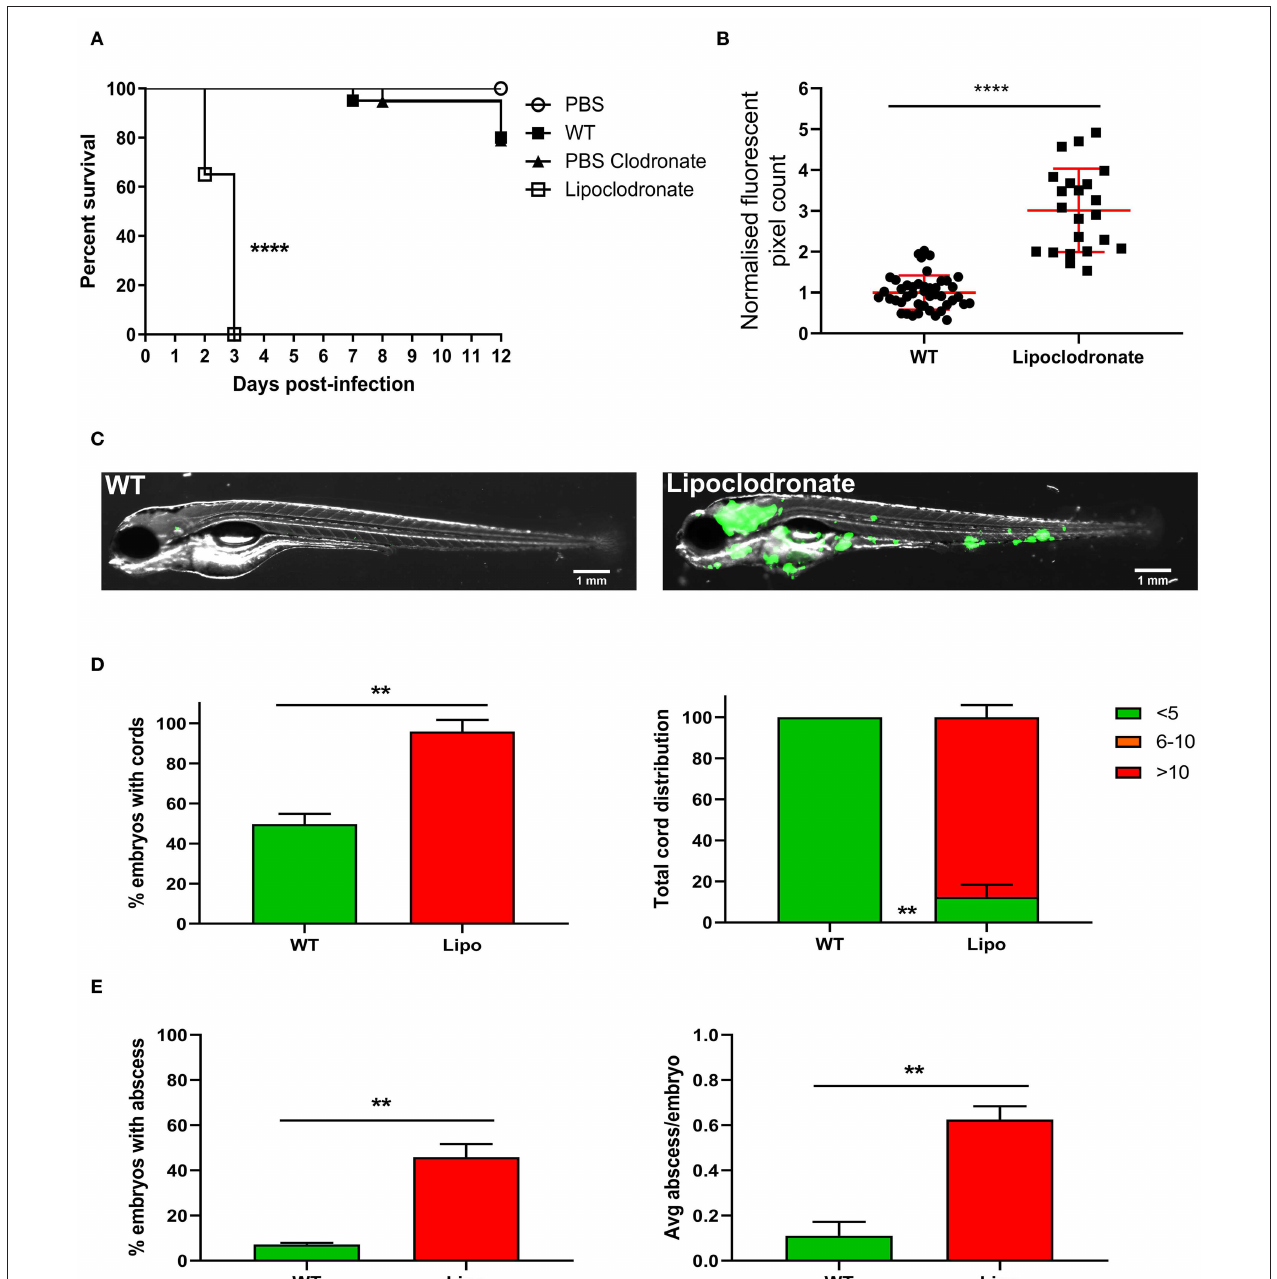
FIGURE 4 | Lipoclodronate macrophage depletion results in lethal M. fortuitum infection. (A) At 24h post-fertilization, embryos were treated with liposomal clodronate via caudal vein injection to transiently deplete macrophages. At 30h post-fertilization, embryos were injected intravenously with 300 CFU of GFP-expressing M. fortuitum with embryo survival monitored over a 12 day period. n = 20–25 embryos/group. Statistical analysis was completed using the log-rank (Mantel-Cox) statistical test for survival curves. Data shown is the merge of two independent experiments. (B) Bacterial burden at 2 days post-infection was calculated using fluorescent pixel count (FPC) determination with ImageJ software. Lipoclodronate-treated embryos were normalized against corresponding controls in each experiment. Each datapoint represents an individual embryo. Error bars represent standard deviation. Statistical significance was determined by Student ′ s t -test. Plots represent a pool of 2 independent experiments containing approximately 20 embryos per group. (C) Representative images of wild-type (WT) and Lipoclodronate-treated embryos infected with 300 CFU of GFP-expressing M. fortuitum at 2 days post-infection. Scale bars represent 1mm. (D) The proportion of embryos with bacterial cords and the total distribution of cords categorized as low ( < 5 cords/embryo), moderate (6–10 cords/embryo) and high ( > 10 cords/embryo) in M. fortuitum -infected embryo at 2 days post-infection. Error bars represent standard deviation. Data shown is the merge of two independent experiments. Statistical significance was determined by Student ′ s t -test. (E) The proportion of embryos with abscesses and the average number of abscesses per infected embryo at 2 days post-infection. Error bars represent standard deviation. Data shown is the merge of two independent experiments. Statistical significance was determined by Student ′ s t -test. ** P ≤ 0.01, **** P ≤ 0.0001.